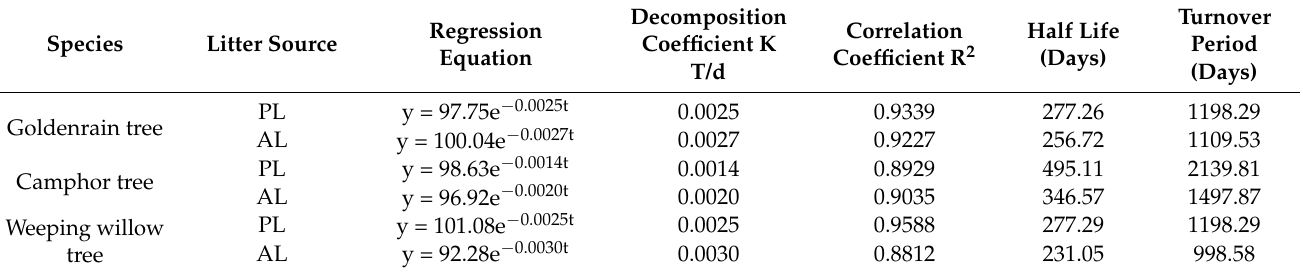
Figure 3. The daily mass loss of goldenrain tree ( a ), camphor tree ( b ), and weeping willow tree ( c ) foliar litter during different critical periods in the urban forest. ALP, WNG, SLP, EPR, and LPR indicate the autumn litter peak period, winter non ‐ growing season, spring litter peak period, early plum ‐ rainy season, and late plum ‐ rainy season, respectively. PL and AL indicate physiological and abnormal litter, respectively. Different capital letters indicate significant differences between differ ‐ ent critical periods ( p < 0.05). Different lowercase letters indicate significant differences between different sources of foliar litter ( p < 0.05).